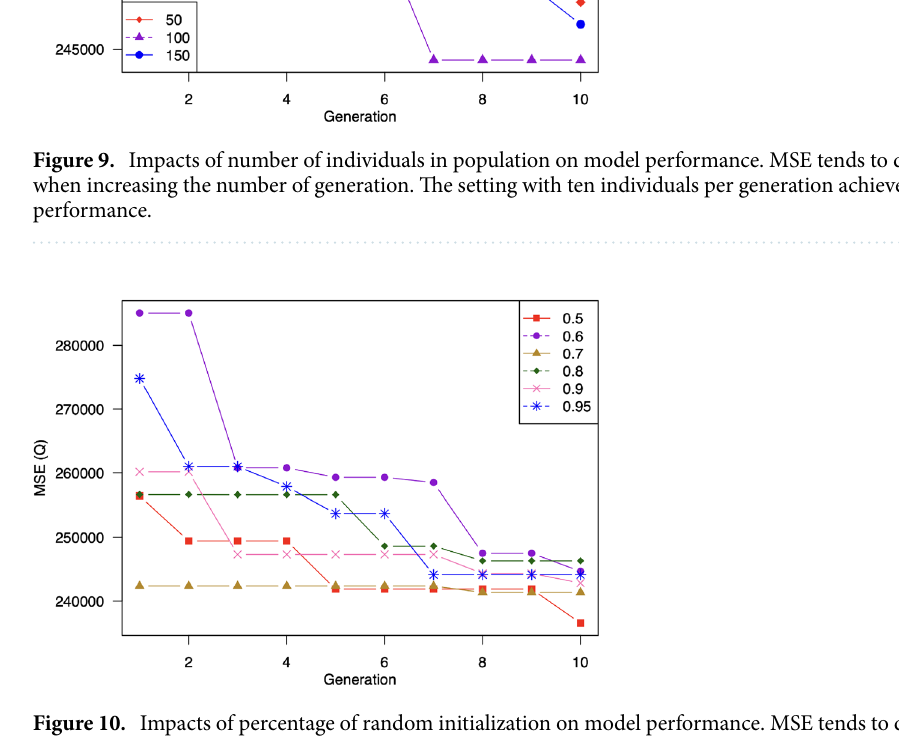
Figure 10. Impacts of percentage of random initialization on model performance. MSE tends to decrease when increasing the number of generation. Using 50% of random initialization achieves the best